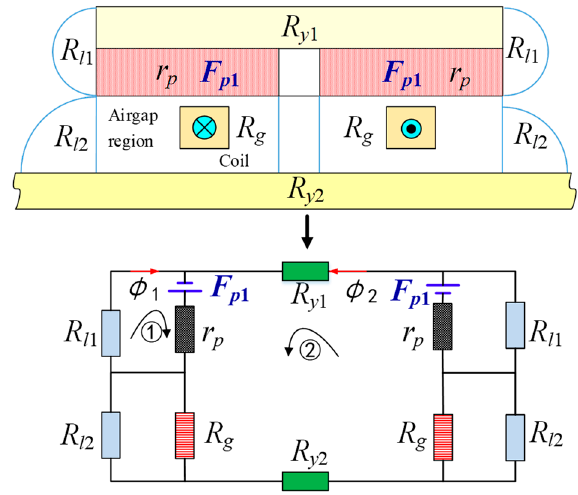
Figure 5. The equivalent magnetic circuit of the driving unit.